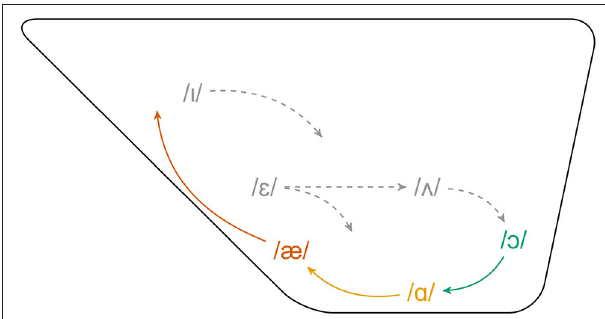
FIGURE 1 | Schematic diagram of the Northern Cities Vowel Shift. Solid, colored lines indicate early stages, dashed gray lines indicate later stages (Adapted from Labov et al., 2006,